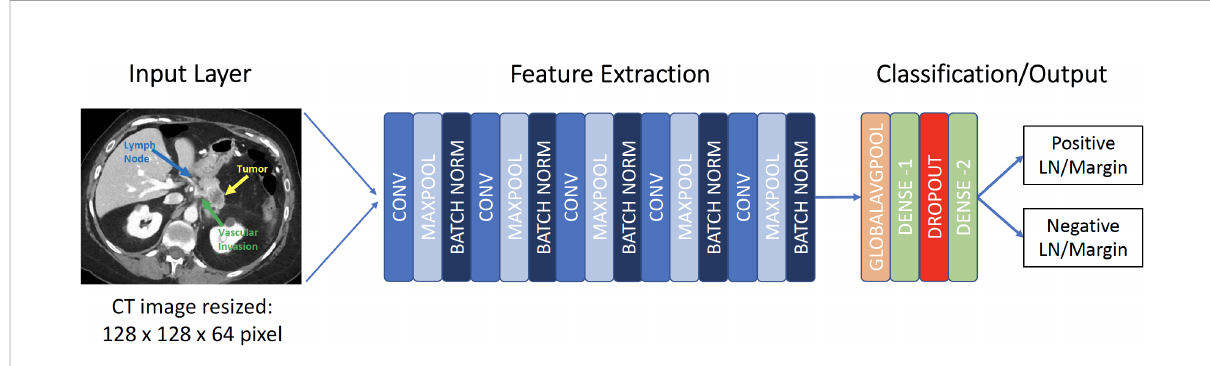
FIGURE 1 Framework for 3D convolutional neural network. CONV, convolutional layer; MAXPOOL, max pooling; LN, Lymph